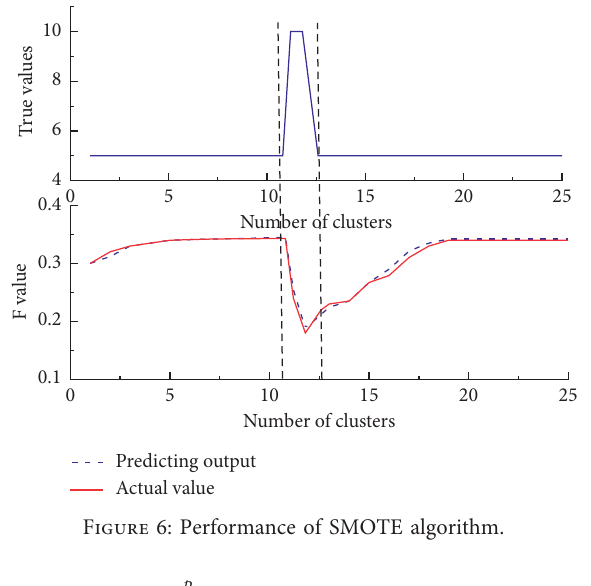
Figure 7: The results of error analysis of this study.